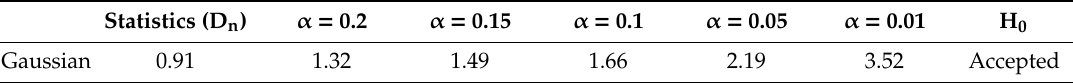
Table 6. Gaussian copula goodness-of-fit test for the Rasht